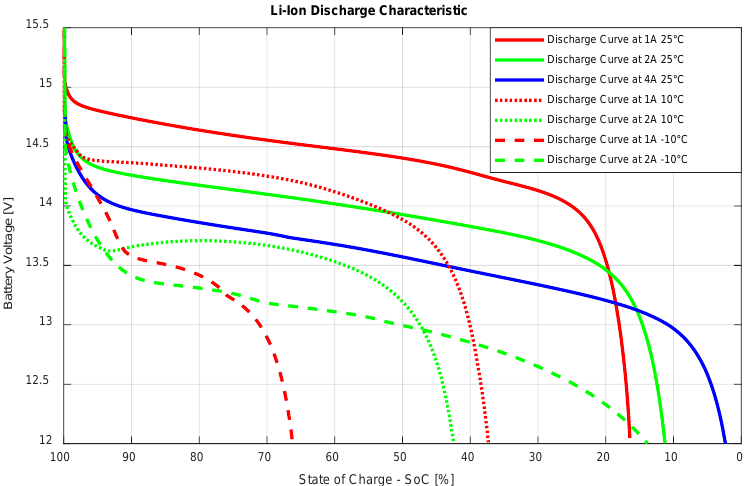
Figure 7. Battery power source comparison.